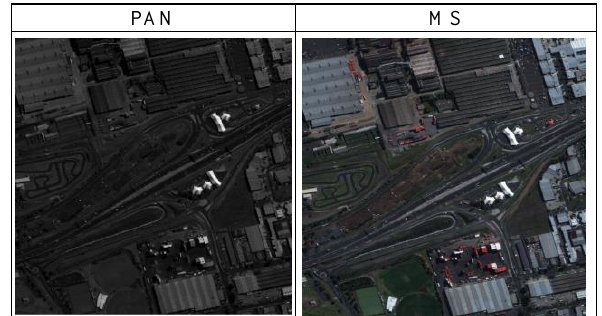
Figure 3. Data set 2, Melbourne image set.